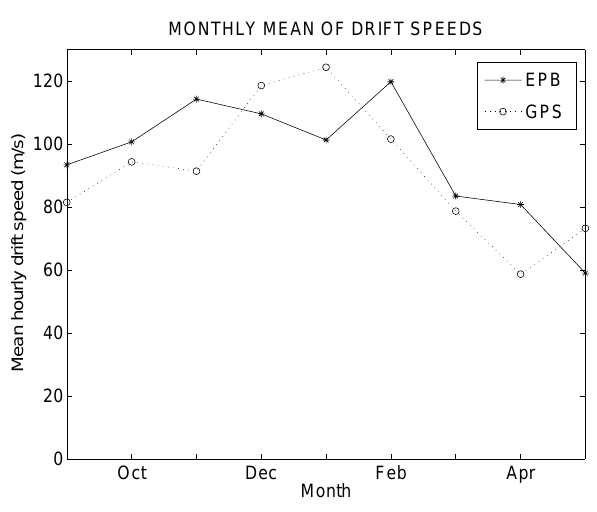
Fig. 8. Annual variation of zonal ion drift speed from EPBs (solid) and from GPS scintillation (dashed) measurements. The EPB trace uses 03:00 LT averages from Fig. 5 because they are available for all months. The GPS scintillation trace is for midnight averages. Both show the winter